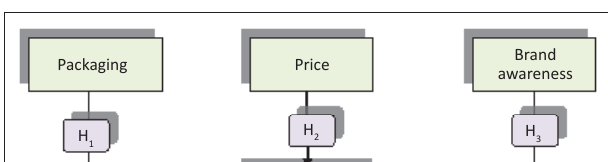
Brand awareness